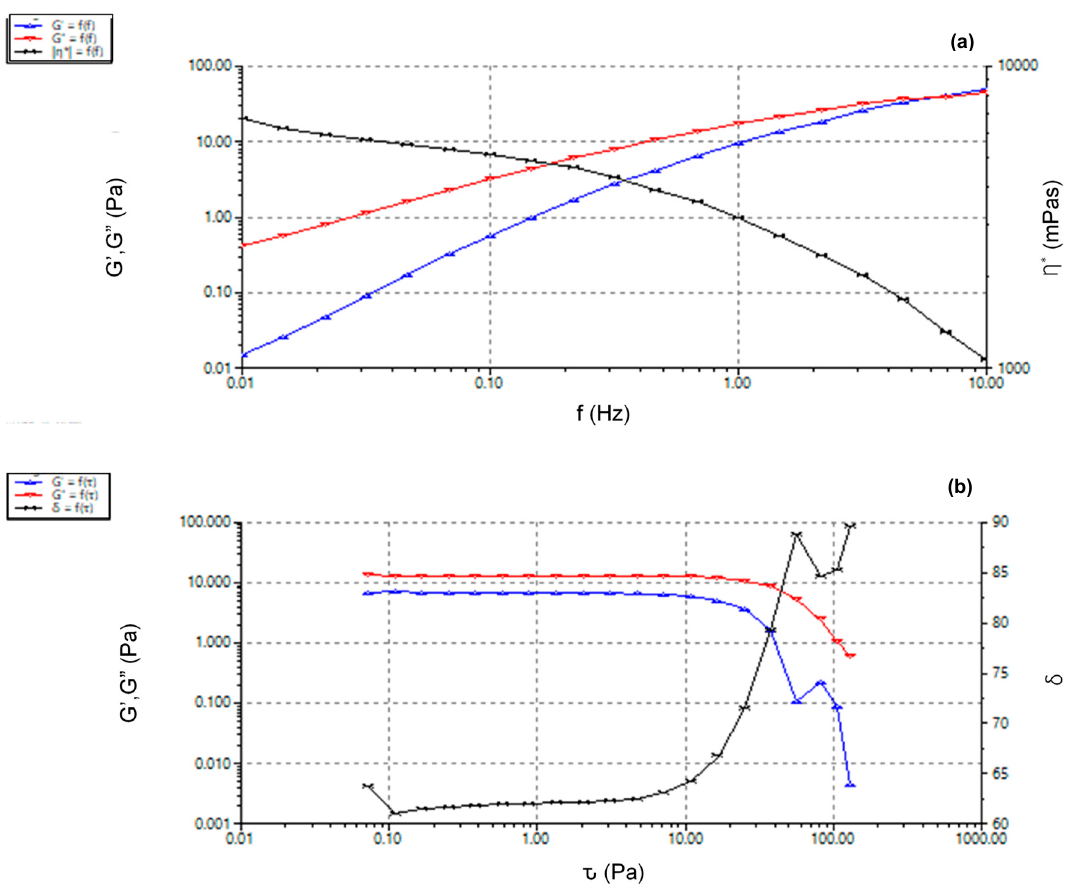
Figure 13. Rheology of HA-NSP ( a ) frequency sweep and ( b )stress sweep.